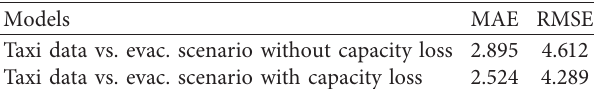
Figure 6: Differences in hourly zonal travel times of Manhattan. Table 7: Validation results of evacuation